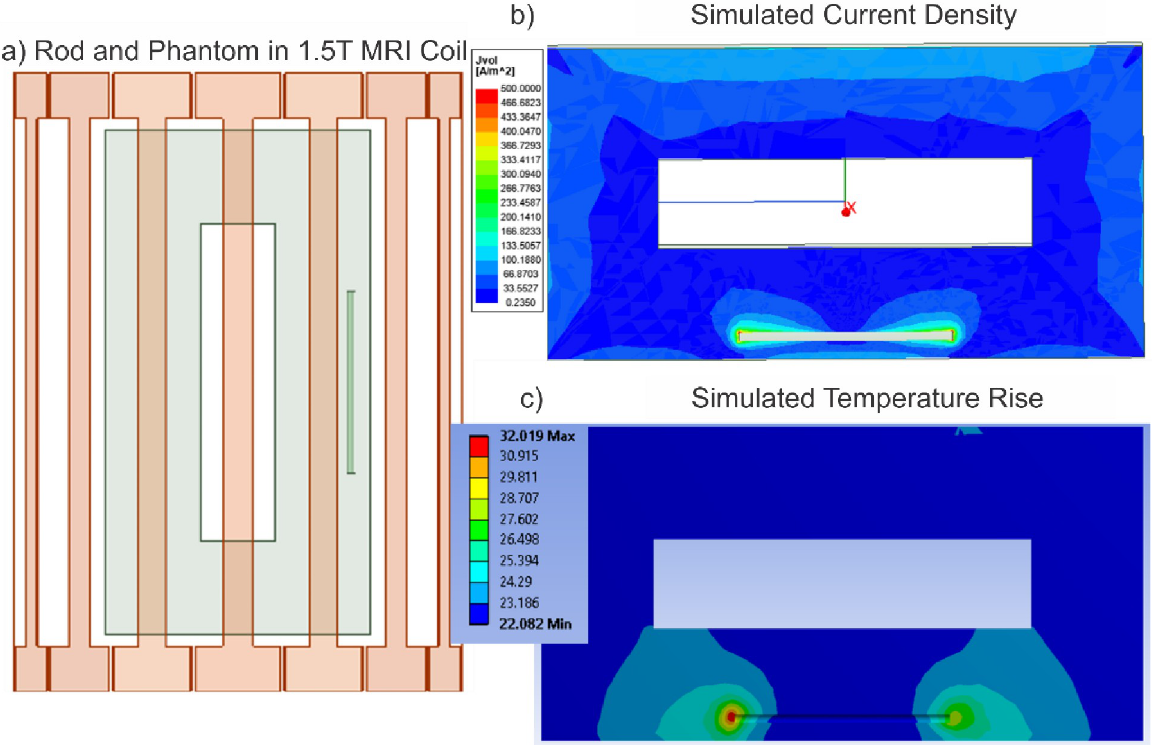
Fig 3. Simulations to establish calibration for experiments conducted in [43–45]. a)–The metallic nail implant placed within a homogeneous loop-like Agar phantom [43–45]at a depth of 2 cm. b)–The current density produced with a whole-phantom SAR of 4.0 W/kg. c)–The simulated temperature given a total volumetric power loss of 120 W exactly corresponding to experiment [43–45].Simulation results produced a temperature rise of 10.02˚C, slightly less than the 12.6˚C experimentally observed in